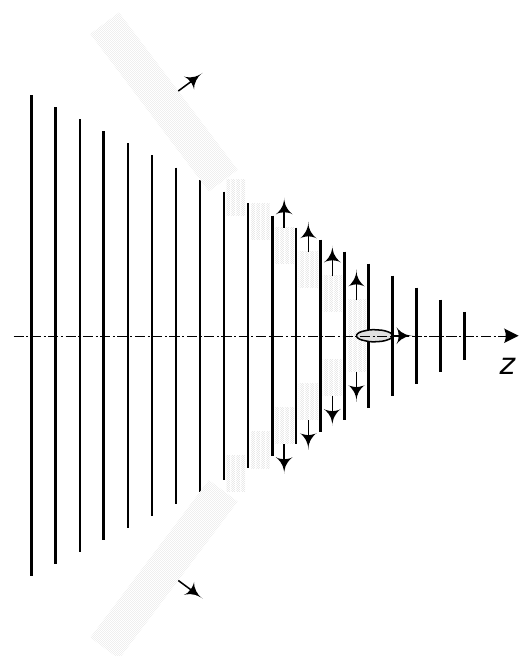
Fig. 2. The scheme of the conical multifoil